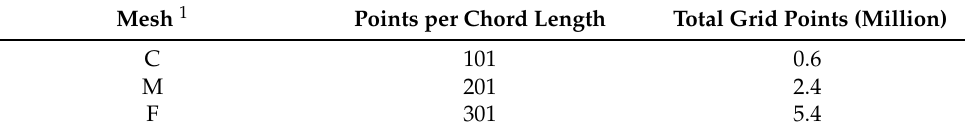
Table A1. Information of the meshes used in the mesh independence test.